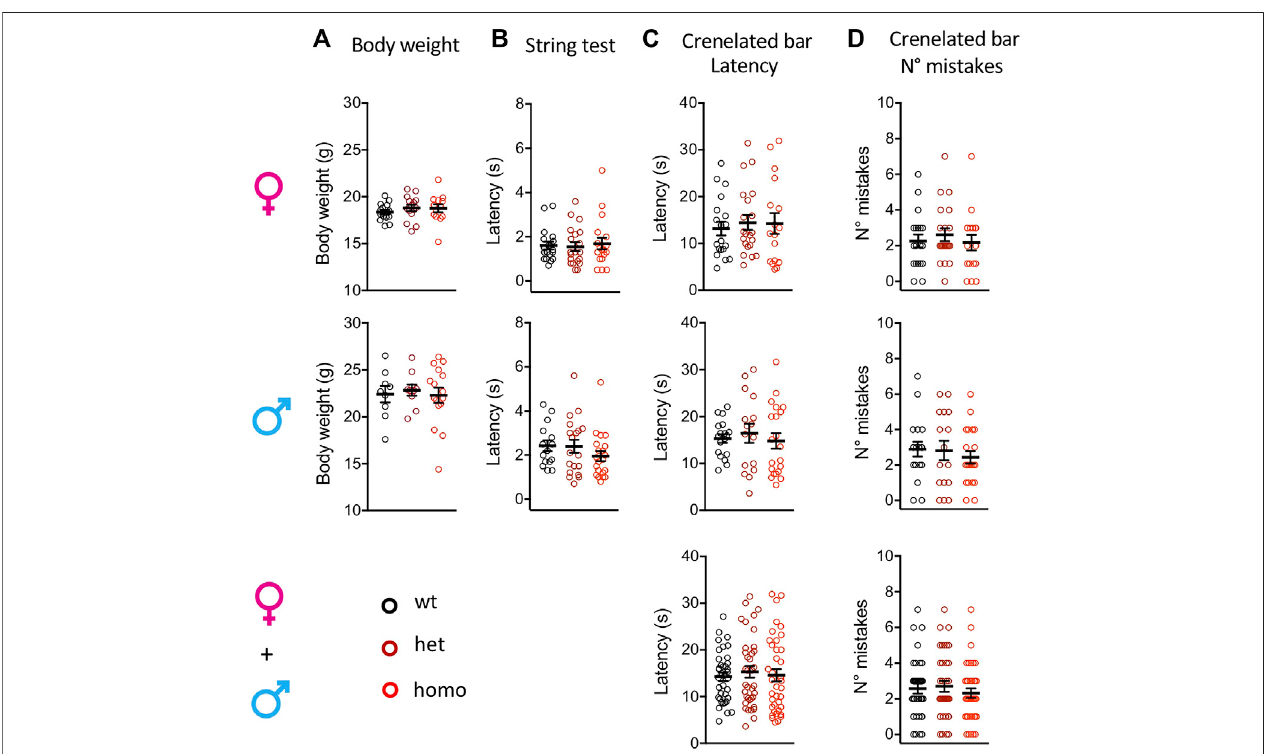
FIGURE 2 | Scn10a G1663S mice show normal healthy conditions and proprioception capacities. (A) Body weight of Scn10a G1663S mice measured at the age of 7 – 11 weeks. Females, n (cid:1) 13 – 15/group; males, n (cid:1) 9 – 16/group. The one-way ANOVA for genotype on separated sexes showed no genotype effect. (B) Muscle strength was evaluated by string test. Females, n (cid:1) 18 – 20/group; males, n (cid:1) 15 – 21/group. A sex effect was detected in the string test. The Kruskal – Wallis test on separated sexes showed no genotype effect. (C-D) Motor coordination and balance were evaluated by the latency and the number of mistakes in the crenellated bar test. Females, n (cid:1) 17 – 21/group; males, n (cid:1) 16 – 21/group. The Kruskal – Wallis tests on separated or grouped sexes showed no sex or genotype effect. Data are expressed as means ± SEM in all panels. See Supplementary Table S5 for detailed statistical